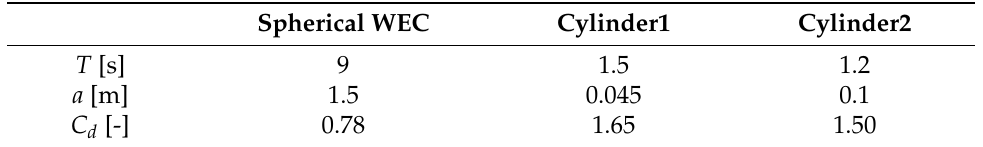
Table 1. Heave amplitude a and heave period T applied during the forced oscillation with Dual- SPHysics of a spherical WEC and two cylindrical WECs, as well as the obtained drag coefficient C d . Spherical